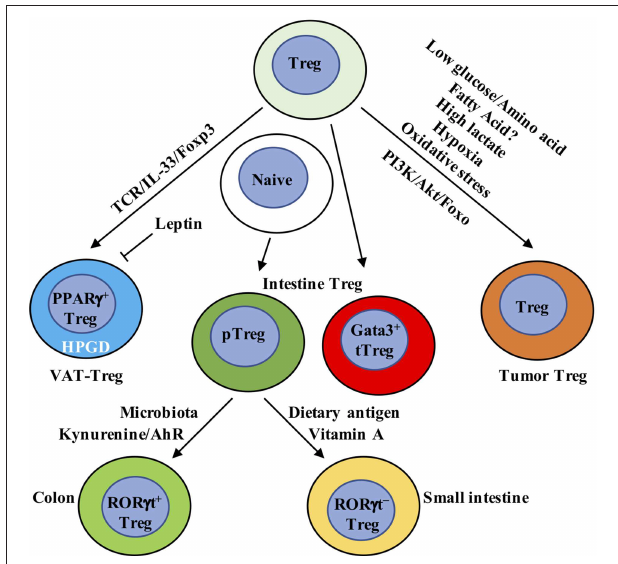
FIGURE 3 | Metabolic and transcriptional adaption in tissue Treg cells. VAT-Treg cell accumulation is dependent upon TCR, Foxp3, and IL-33 signaling. VAT macrophages and DCs are the major antigen-presenting cells that express MHC-II to activate and increase VAT-Treg cells. In VAT, white adipose tissue produces IL-33 to increase VAT-Treg cell generation. Leptin produced by adipose cells inhibits VAT-Treg cell proliferation and induces anergy. Leptin-neutralizing antibody reverses anergy and increases mTOR activation and Treg cell proliferation. VAT-Treg cells have high expression of enzyme hydroxyprostaglandin dehydrogenase (HPGD), which is dependent on PPAR γ . HPGD produces 15-keto PGE 2 to suppress conventional T cell activation and proliferation. Intestinal Treg cells mainly contain Gata3 + tTreg, ROR γ t + , and ROR γ t − pTreg cells. ROR γ t + pTreg cells are the dominant population in the colon, while ROR γ t − pTreg cells mainly localize in small intestine. Their difference is mainly derived from the dominant effect of microbiota and dietary metabolites, respectively, in the colon and small intestine. In the colon, metabolism of tryptophan produces AhR ligands, such as kynurenine, to selectively enhance the generation of Foxp3 + Treg cells. In the small intestine, dietary vitamin A is present at high concentrations. RA, a metabolite from vitamin A, induces pTreg cells from naïve T cells in the small intestine in combination with TGF- β . RA also induces the expression of CCR9 on the surface of Treg cells to facilitate their migration to the small intestine. In tumor tissue, Treg cells not only display eTreg cell phenotypes similar to non-lymphoid organs but also express some tumor-specific gene signatures. Compared to conventional T cells, Treg cells have a metabolic advantage in tumor microenvironment, which has low glucose/amino acid, high lactate/hypoxia, and elevated oxidative stress. Genetic or pharmacological perturbation of metabolic pathway PI3K/Akt/Foxo signaling directly impacts tumor-resident Treg cell homeostasis, function and anti-tumor immunotherapy. VAT, visceral adipose tissue; AhR, aryl hydrocarbon